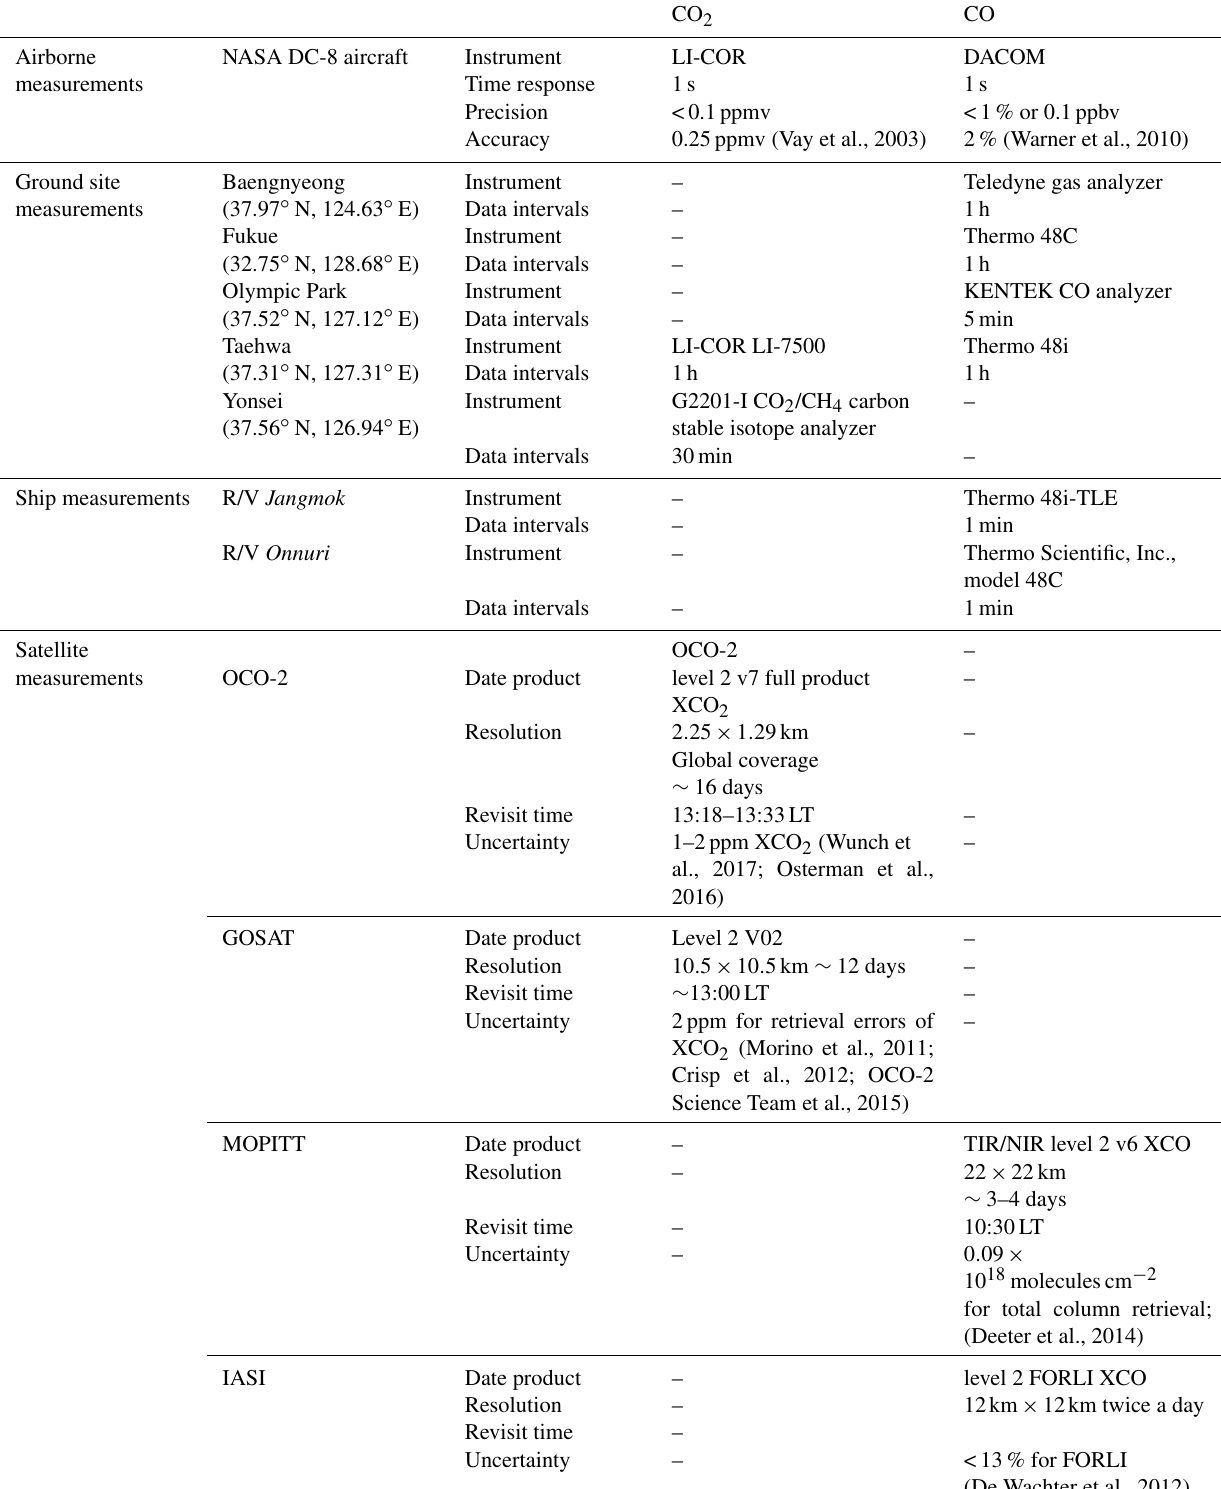
Table 2. Measurements during